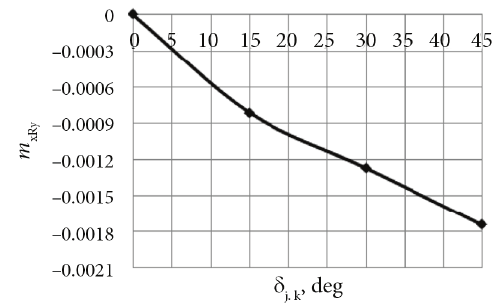
Figure 4. Change of δ ∆ r